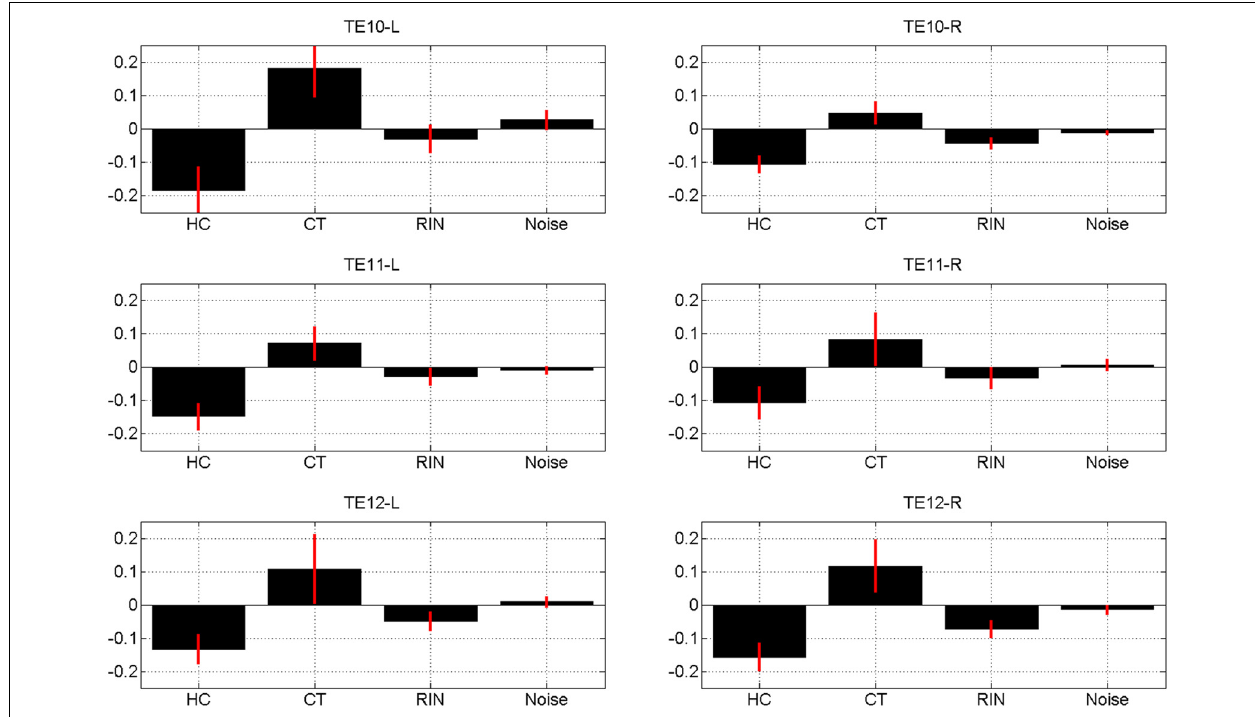
FIGURE 4 | Magnitude of repetition suppression effect, a k averaged over sessions, for conditions k = 1 , 2 , 3 , 4 (Harmonic Complex—HC, Click Train—CT, Random Interval Noise—RIN, Noise). The red error bars indicate the standard deviations. Positive values indicate